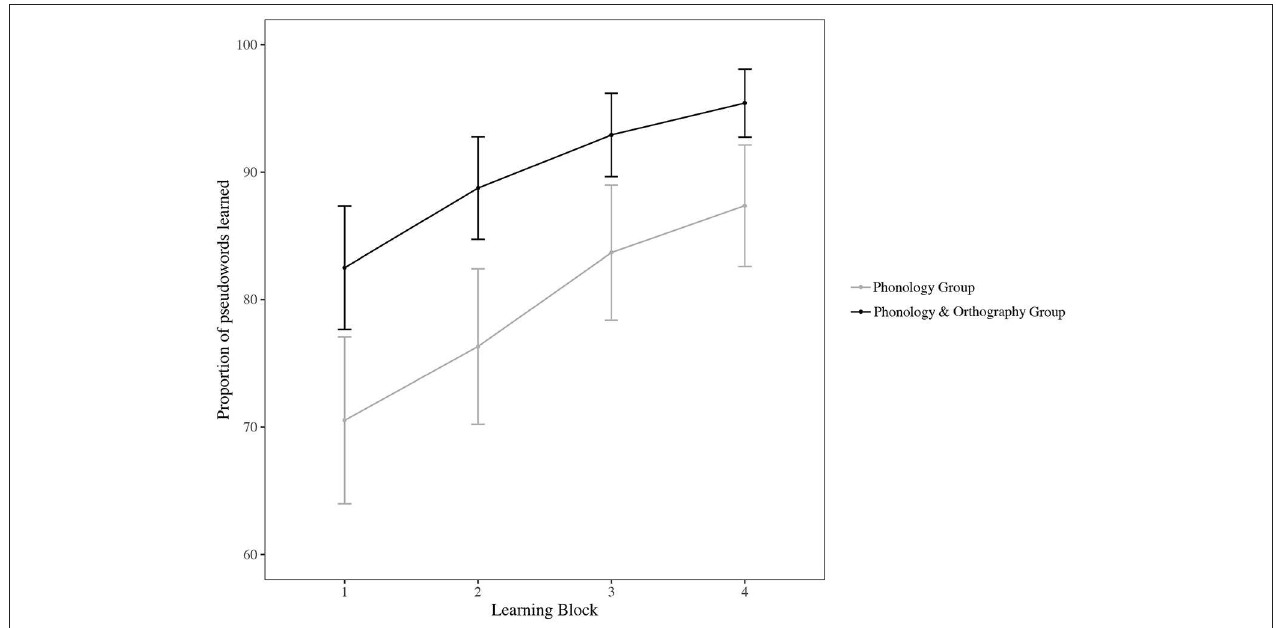
FIGURE 2 | Mean percentage of pseudowords recalled and correctly produced as a function of group (Phonology, Phonology & Orthography) and learning block (1, 2, 3, 4). Bars represent 95% CI s.